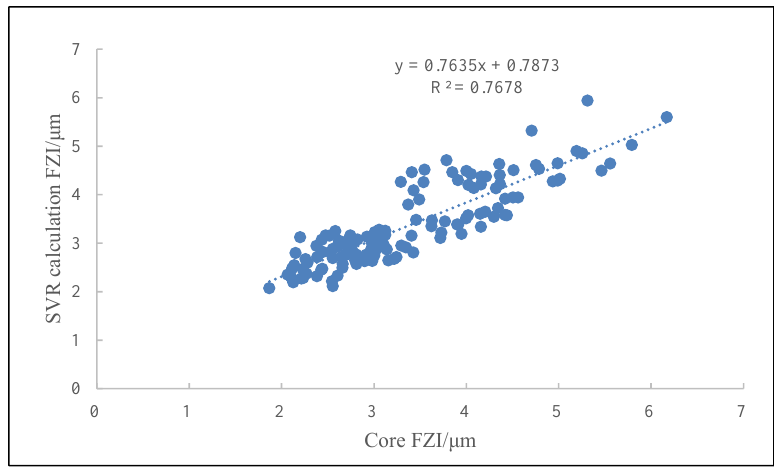
Figure 11. The relationship between the core FZI and the calculated FZI by SVR.